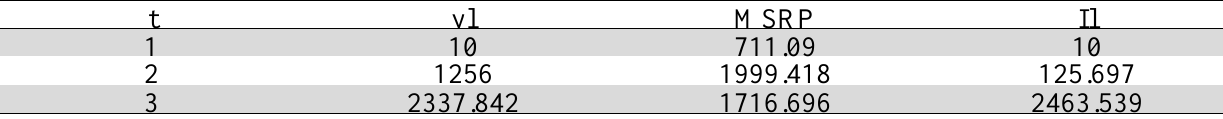
The results of MSRP